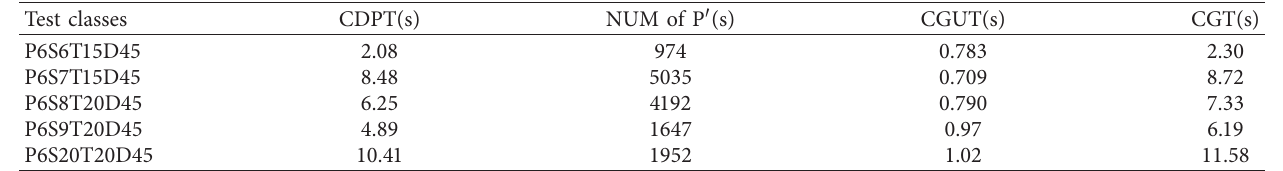
Table 7: CGSPA reliability analysis.